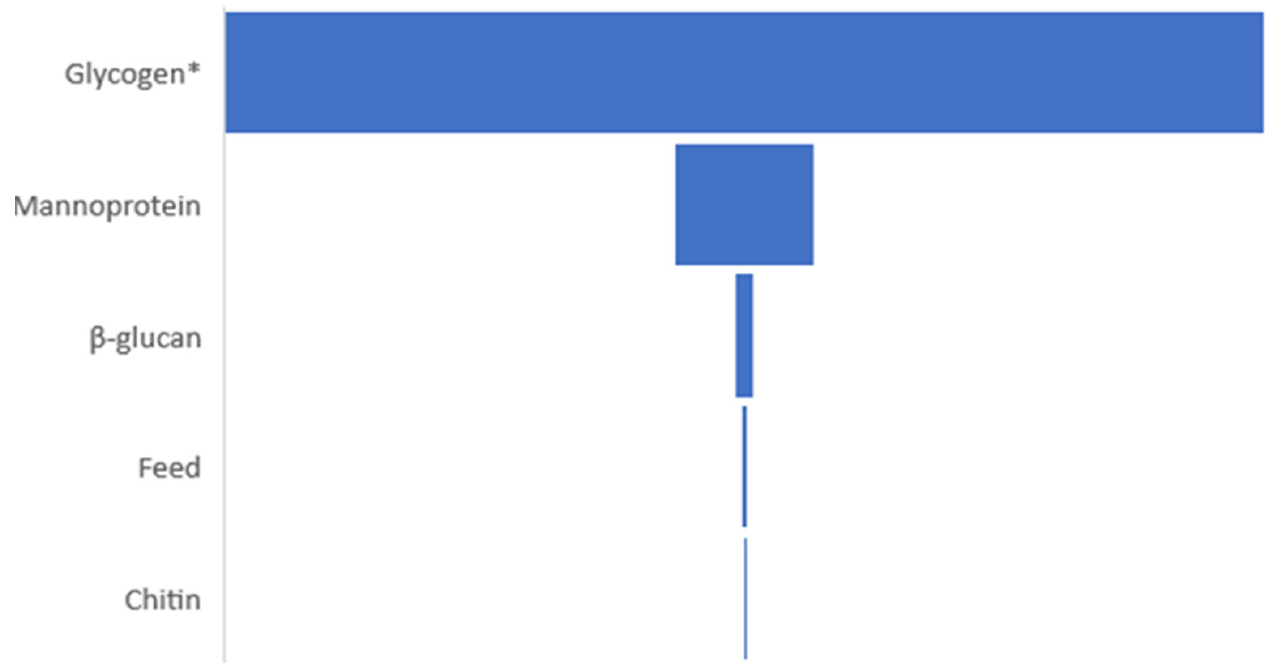
Figure 2. Indicative income ratios of high-value products per dry-matter ton of SBY in comparison to feed. * Glycogen from SBY was not detected in the market